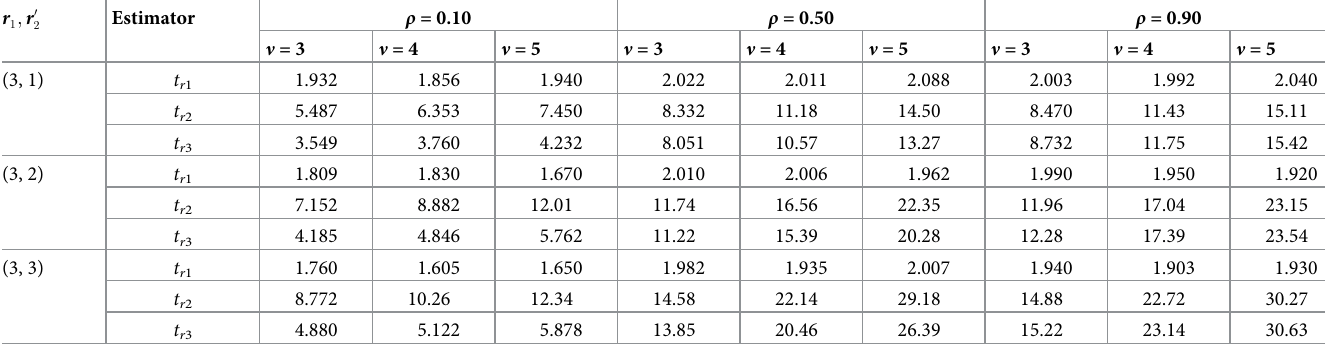
Table 4. RE of proposed class of estimators for Situation-II when k = 2. r 1 ; r 0 2